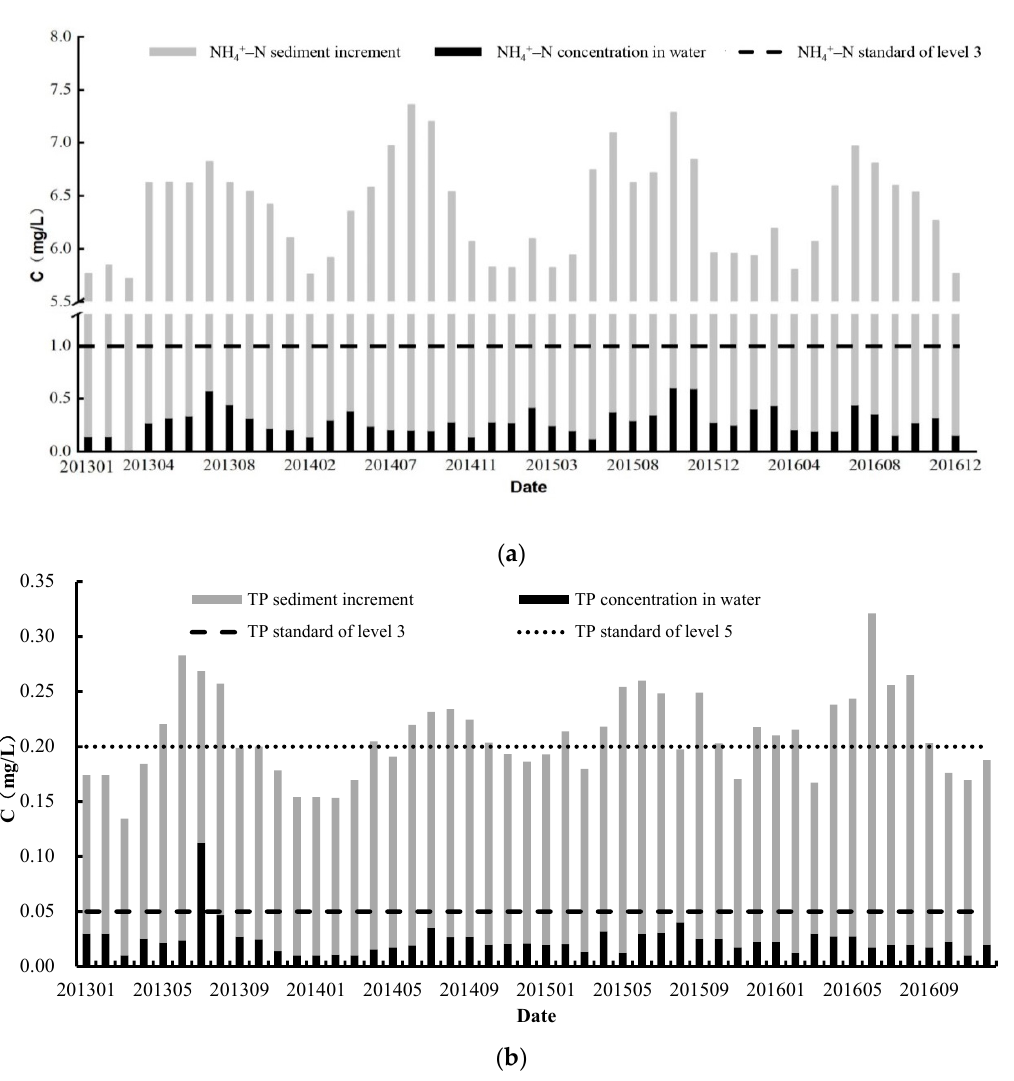
Figure 8. The sediments increment of NH 4+ –N and TP of Biliuhe reservoir from 2013 to 2016: ( a ) the sediments increment of NH 4+ –N; ( b ) the sediments increment of TP.